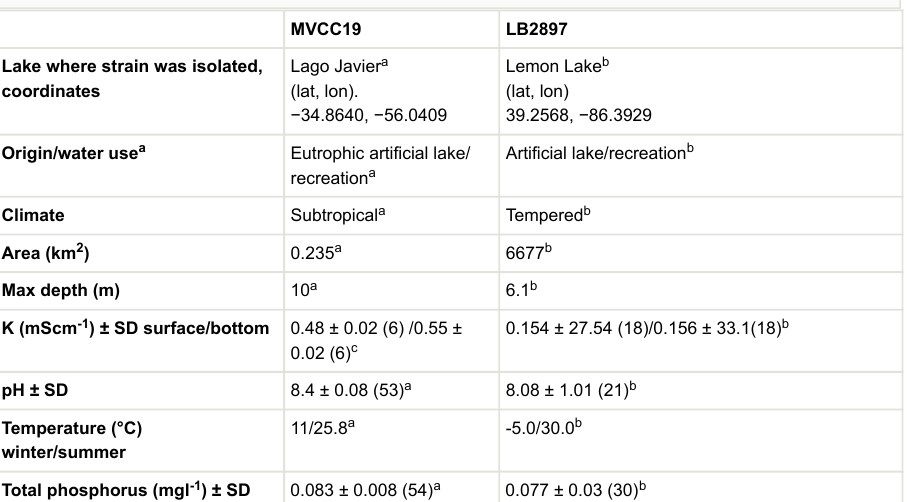
Morphology, toxicity and biogeographic characteristics of R. raciborskii MVCC19 and R. raciborskii LB2897. K, conductivity. SD, standard deviation. STX, saxitoxin and analogues. CYN, cylindrospermopsin. Number of data is indicated within brackets. Bonilla et al. 2016, Clark and Jones 2006,2011,2013, Soma et al., pers comm., Piccini et al. 2011, Vico et al.